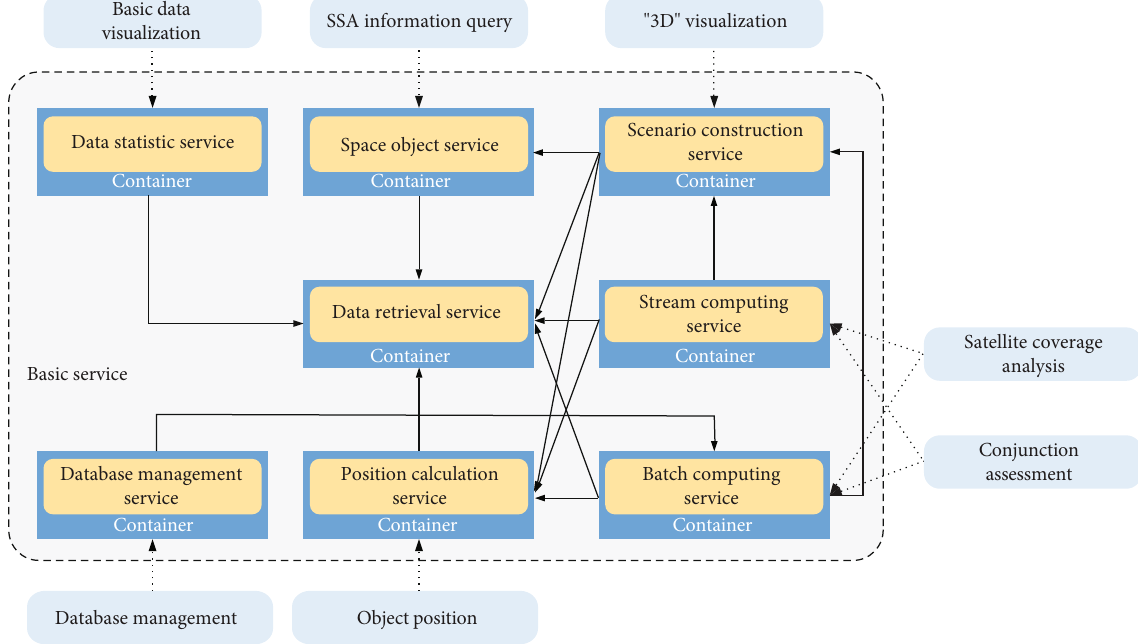
Figure 6: Service dependencies of the basic service. Examples of the applications that invoke the basic services are listed outside the basic service